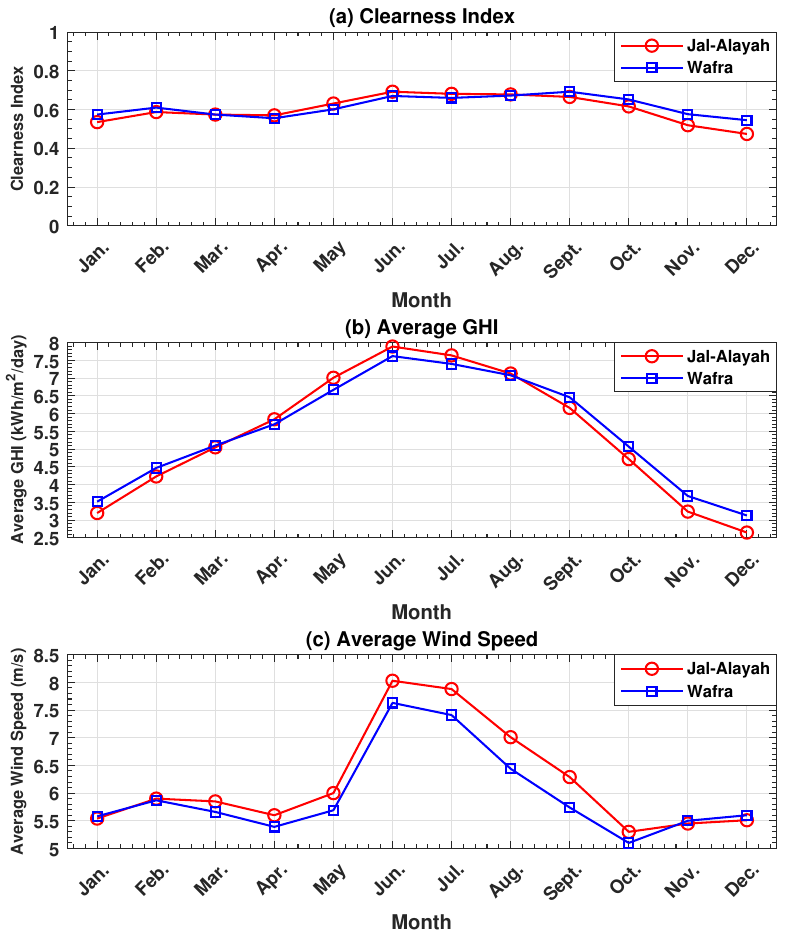
Figure 6. ( a ) Clearness Index, ( b ) Average GHI, and ( c ) Average Wind Speed of Jal-Alayah and Wafra